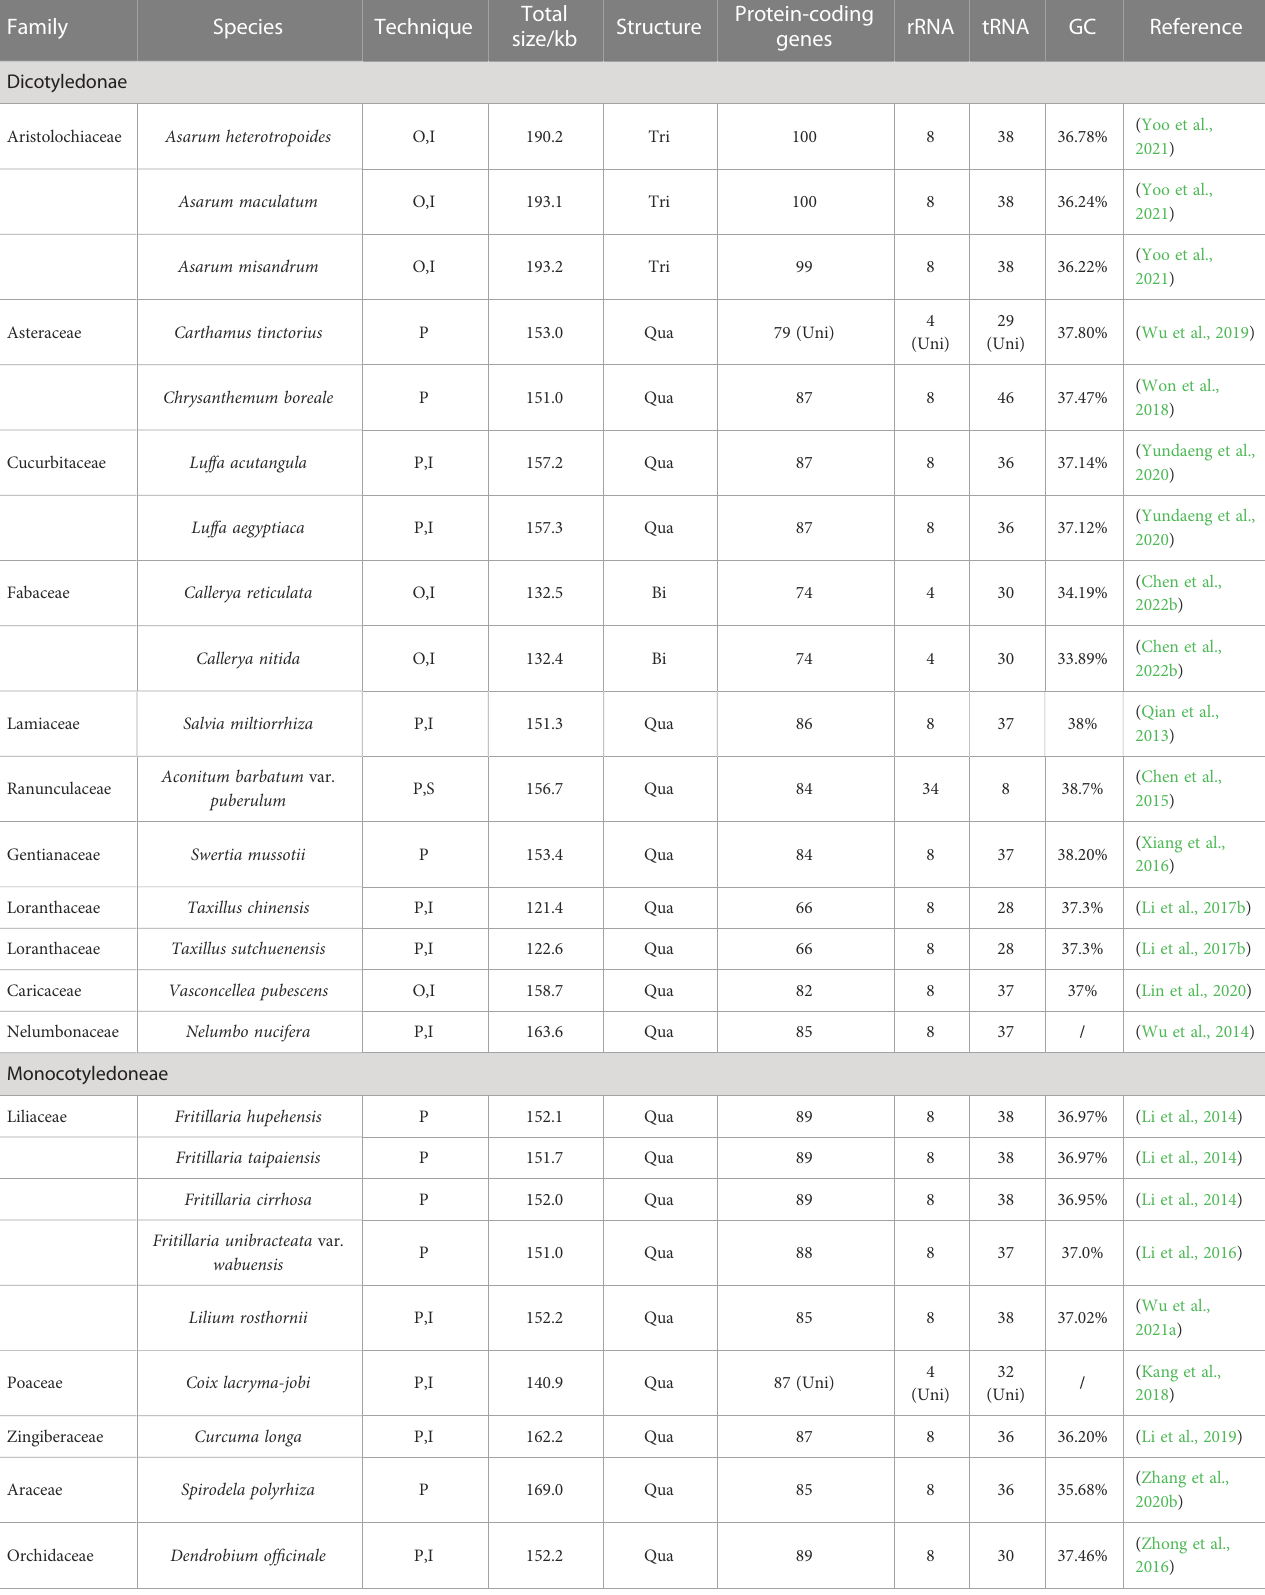
TABLE 2 Chloroplast genome assemblies obtained using TGS techniques. Family Species Technique